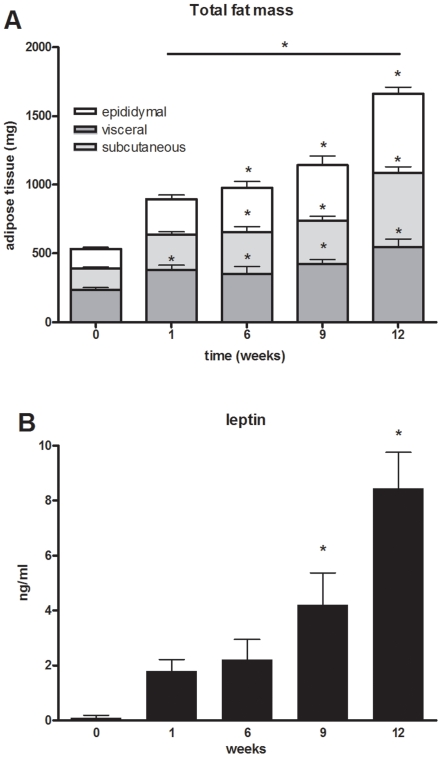
Fat mass over time.(A) Bars represent total fat mass subdivided into the epididymal, subcutaneous and visceral adipose tissue depots. Groups of n = 15 animals were sacrificed at the time points indicated to determine adipose mass of the various depots. Data are presented as means ± SEM. *P<0.05 indicates significance compared to t = 0 for each type of adipose tissue depot or the total fat mass. (B) Plasma leptin levels over time presented as means±SEM. *P<0.01 compared to t = 0.